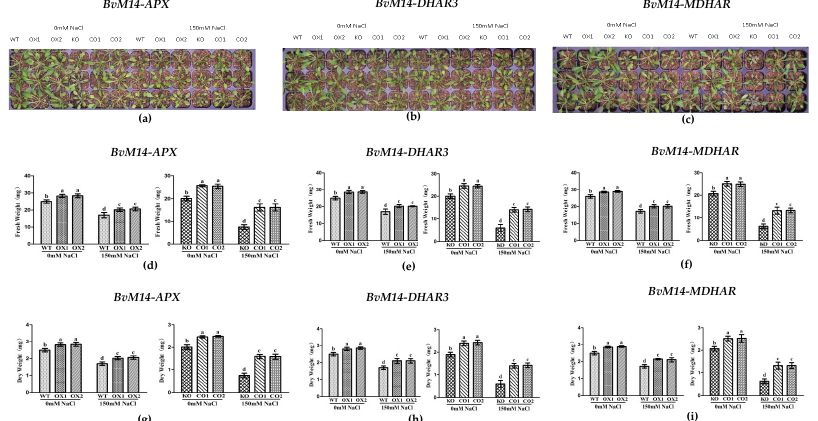
Figure 2. Effects of salt stress on the phenotype and biomass: ( a ) Phenotype of WT and APX - related plants under salt stress; ( b ) phenotype of of WT and DHAR3 -related plants under salt stress; ( c ) phenotype of WT and MDHAR -related plants under salt stress; ( d , g ) biomass of WT and APX - related plants under salt stress; ( e , h ) biomass of of WT and DHAR3 -related plants under salt stress; ( f , i ) biomass of WT and MDHAR -related plants under salt stress. Data were analyzed by Duncan’s analysis of variance, and different lowercase letters (a, b, c, d) indicate differences in fresh and dry weight.